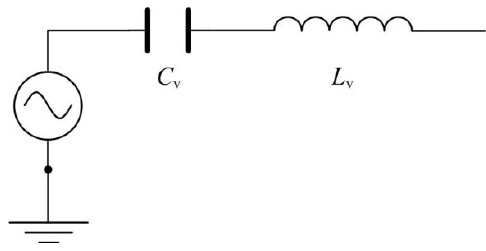
Figure 3. Equivalent circuit of a piezoelectric vibrator.